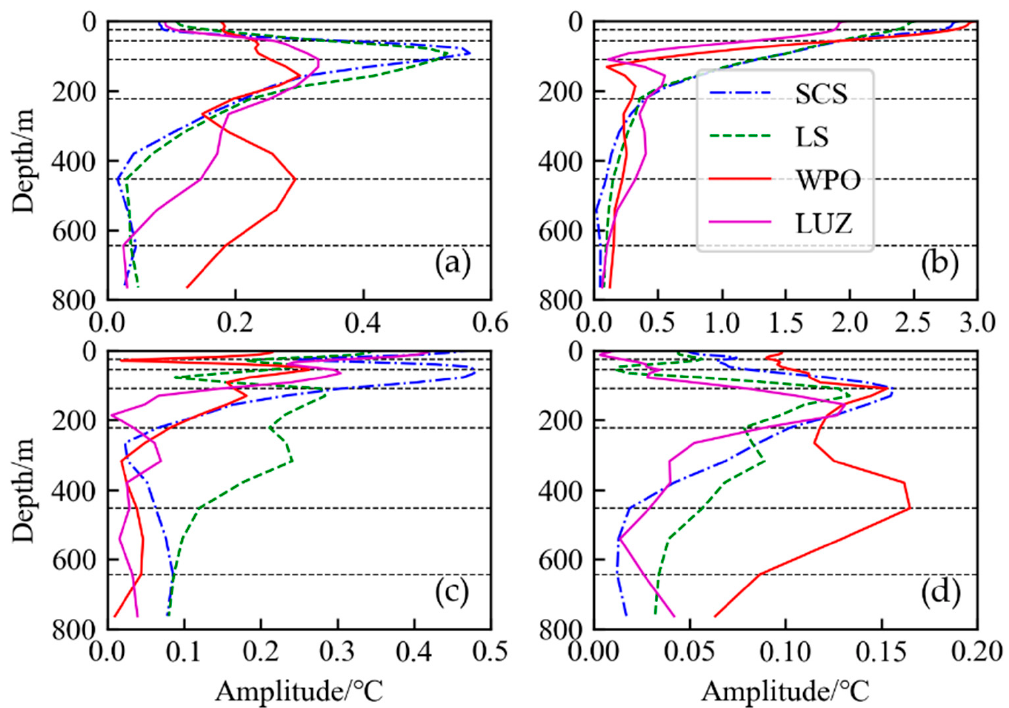
Figure 4. Vertical profiles of each of the four selected signal components (see Figure 3 for details). The black dotted lines (from top to bottom) in each subgraph indicate water depths of 25, 56, 110, 222, 454 and 644 m, respectively. ( a ) 2.5-year; ( b ) 1-year; ( c ) 0.5-year; ( d ) 0.2-year cycles, respectively.